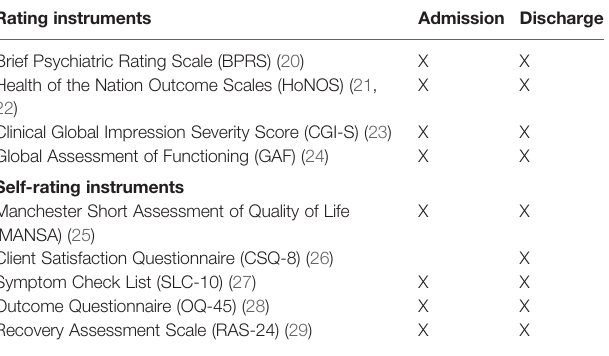
TABLE 1 | Overview of the rating instruments and time of